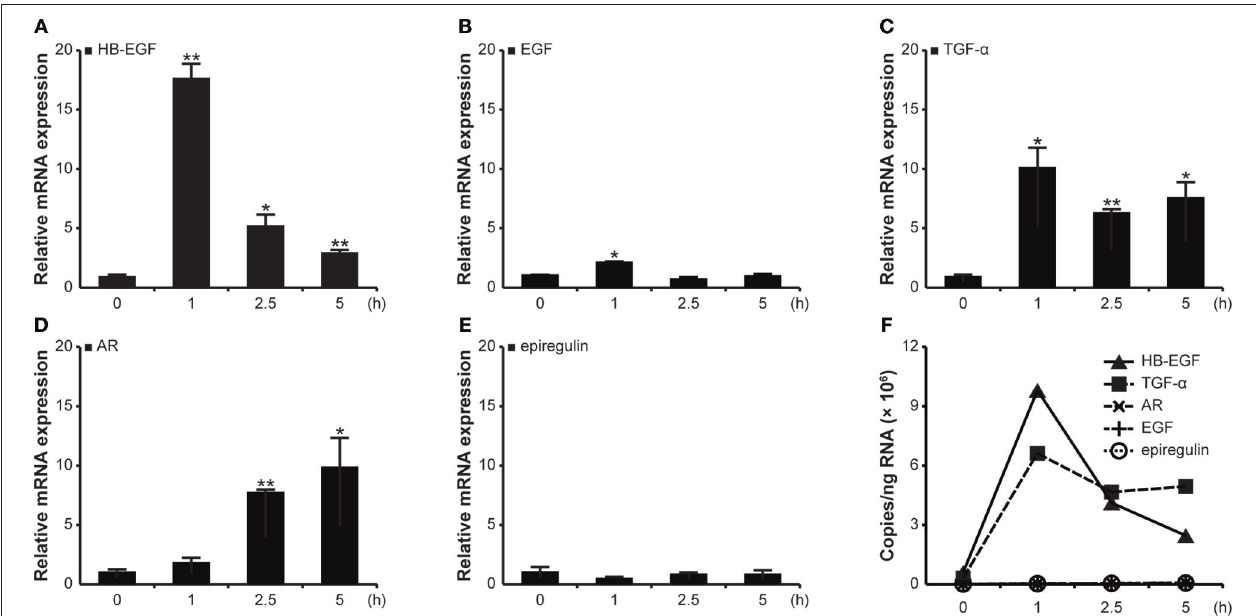
FIGURE 2 | Relative and absolute quantification of transcription levels of EGF family members in AGS cells after H. pylori infection. AGS cells were infected with G27 WT for the indicated durations. Transcriptions of HB-EGF, TGF- α AR, EGF, and epiregulin were relatively quantified by qRT-PCR. (A–E) The results were expressed as relative transcription levels of each EGF family gene to those of the uninfected cells. Each result is presented as mean values ± SD of three independent experiments performed in triplicate. * P < 0.05, ** P < 0.01. (F) The absolute levels of transcription of all EGF family genes are shown together.